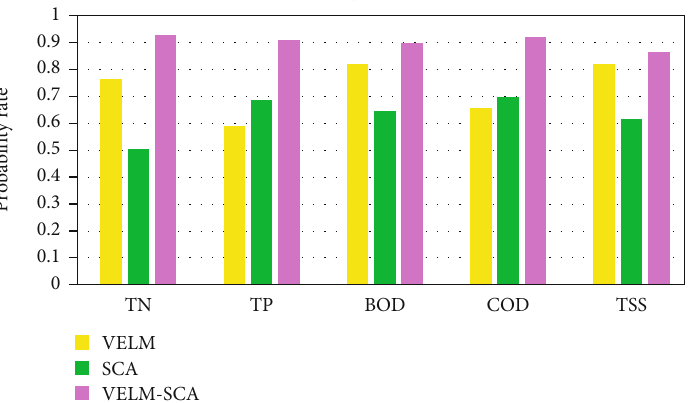
Figure 3: Probability prediction of carbon. Table 7: E ff ectiveness. E ff